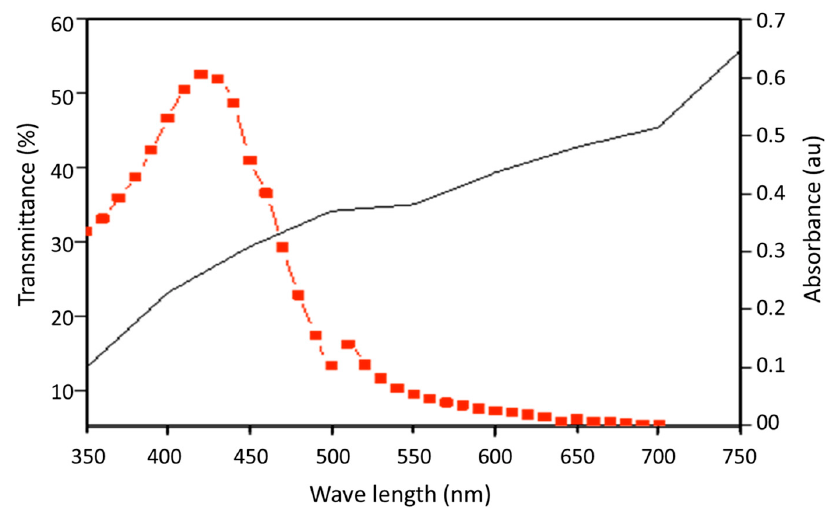
Figure 2. Light transmittance (%) of shrimp carapace (black) and absorbance spectrum (red) of curcumin.